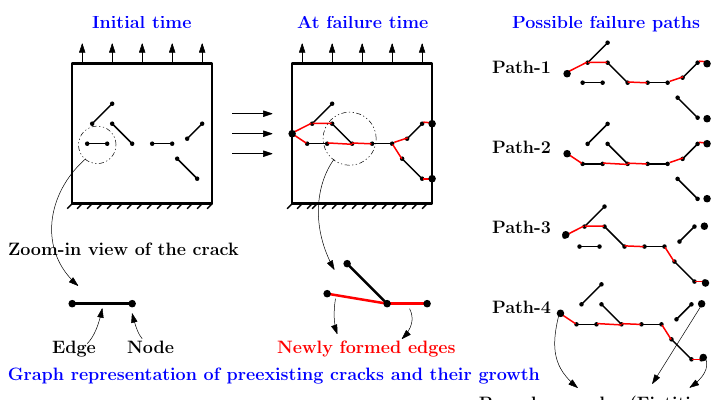
Figure 3. Failure paths graph representation: A pictorial description of graph representation of fracture propagation. Crack tips are graph nodes and edges are cracks (which are assumed to be line segments connecting crack